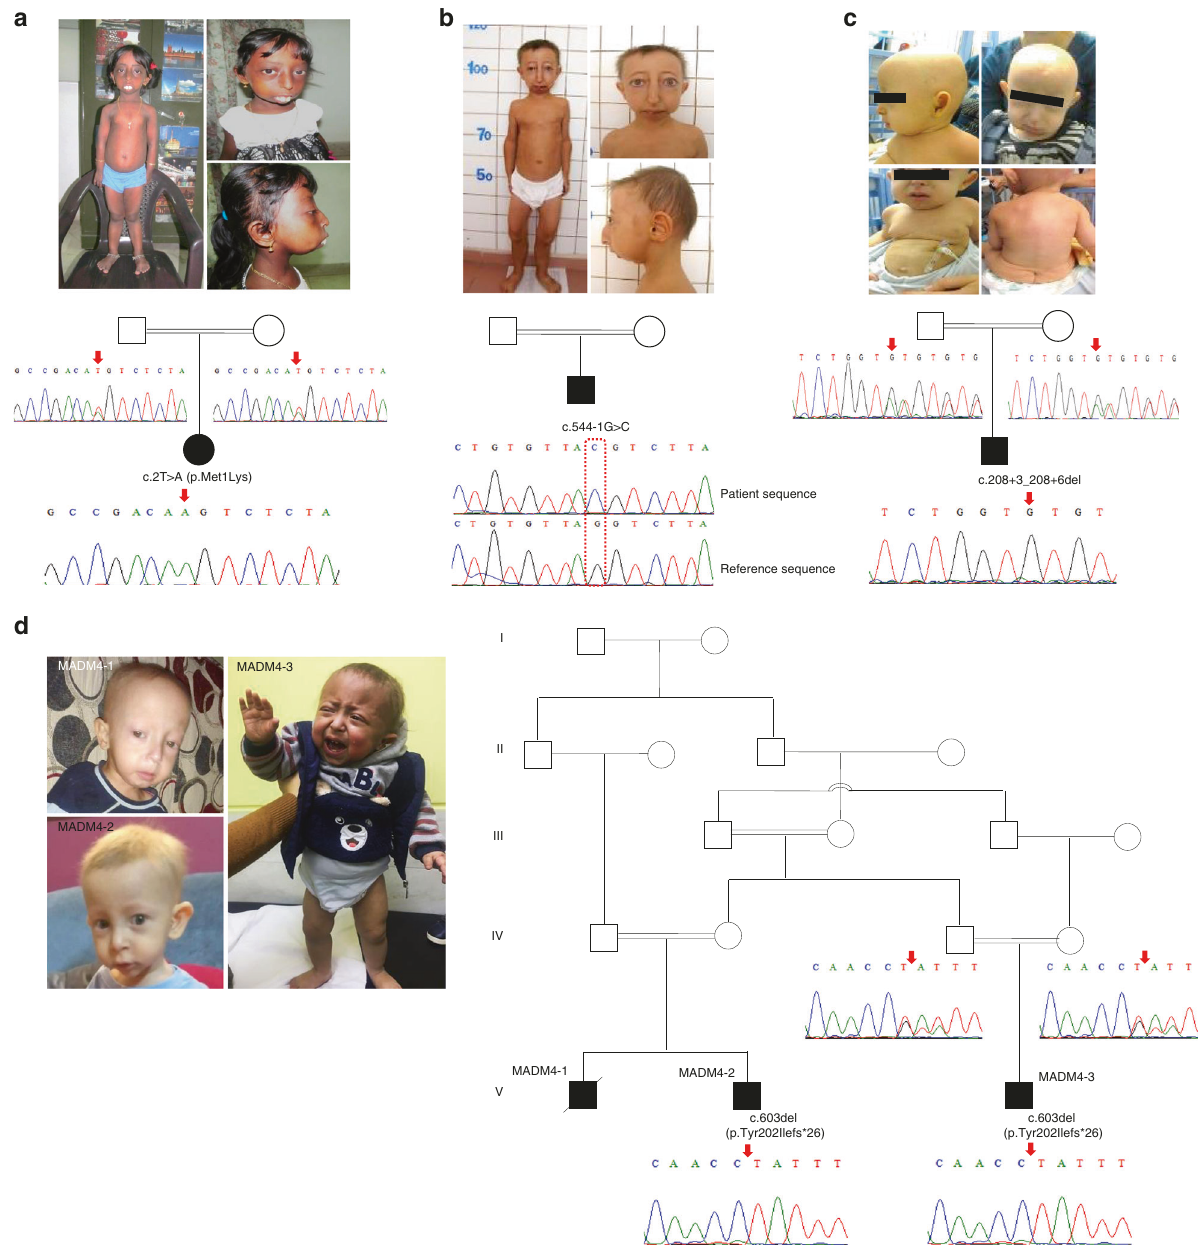
Fig. 1 Patients ’ clinical features and MTX2 mutations. a Pictures and electropherograms of patient MADM1. At age 11 years, the girl showed severe growth retardation, mandibular recession, a pinched nose with hypoplastic alae nasi , long philtrum, prominent eyes, dental overcrowding, sparse eyebrows and body hair along with lipodystrophy and atrophic wrinkled skin. The homozygous c.2T>A (p.Met1Lys) MTX2 variant was identi fi ed and the heterozygous state of the parents con fi rmed the mode of inheritance as autosomal recessive. b Pictures and electropherograms of patient MADM2 at age 14 years, showing clinical features very similar to patient MADM1. The homozygous c.544-1G>C MTX2 splicing variant was con fi rmed by Sanger sequencing. c Pictures and electropherograms of patient MADM3 at age 2 years. He showed mandibular recession, prominent eyes, alopecia, long Stahl ’ s ears, and lipodystrophy. The homozygous c.208 + 3_208 + 6del MTX2 splicing variant was observed and con fi rmed by Sanger sequencing, and the carrier state of the parents was in accordance with autosomal recessive inheritance pattern. d Pictures of patients and family tree of the MADM4 consanguineous family. The homozygous MTX2 deletion c.603del (p.Tyr202Ilefs*26) was identi fi ed in three affected children (MADM4-1, MADM4-2, MADM4-3), all presenting with progeroid facies including high forehead, bulbous nose with depressed nasal bridge, prominent eyes, long philtrum, small mouth, small mandible, and long Stahl ’ s ears. Informed consent was obtained to publish patient images. See Supplementary Note 1, Supplementary Figs. 1, 2, and Supplementary Data File for additional clinical and radiological